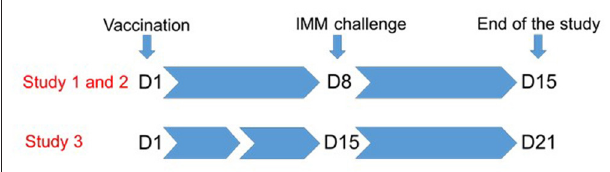
FIGURE 1 | Overview of the study design. Lambs were weaned from their mothers 24h prior to immunisation at D1. Each ewe was immunised subcutaneously in the udder skin (study 1) or directly into the mammary gland through the teat canal (studies 1, 2, and 3). Animals were challenged by infusion of the teat canal with M. haemolytica at D8 (study 1 and 2), or at D15 days (study 3). Animals were followed for 7 days after